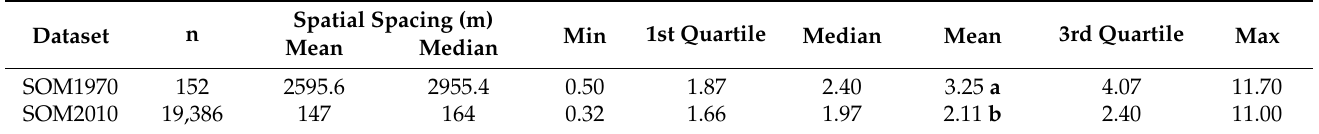
Table 1. Descriptive statistics of the SOM datasets. Min—minimum, Max—maximum. Different letters represent significant differences at p <